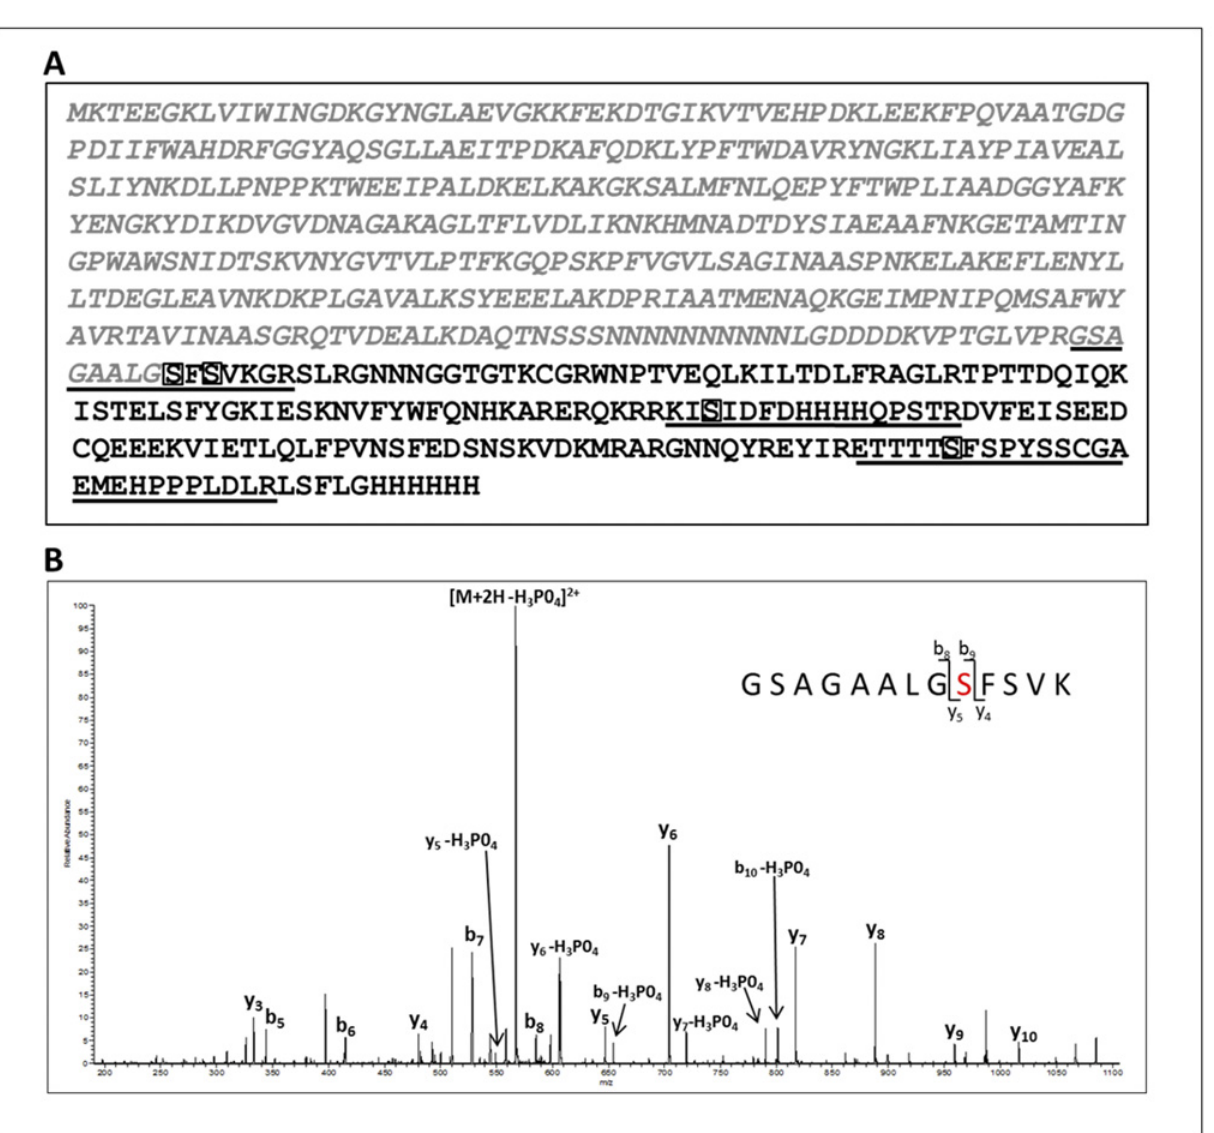
Fig 9. Identification of in vitro WOX5 phosphorylation sites. (A) The sequence of the MBP fused WOX5 protein is shown: the N-terminal MBP fusion tag (grey italics) and the 182aa WOX5 sequence with the C-terminal 6X-His tag (black). Note, the N-terminal Met residue of WOX5 was changed to Gly. Confirmed phosphorylation sites, Ser 2 , Ser 4 , Ser 88 , and Ser 158 are boxed. The phosphopeptides identified by mass spectrometry are underlined. (B) Collision-induced low resolution fragmentation spectrum of the phosphopeptide GSAGAALGSFSVK, encompassing the C-terminal end of the fusion tag and the N-terminal end of WOX5. The presence of the phosphorylated b 9 (theoretical m/z 654.32, observed m/z of 654.33) and y 5 (theoretical m/z 549.30, observed m/z of 549.33) ions, and the unphosphorylated b 8 (theoretical m/z 585.30, observed m/z of 585.17) and y 4 (theoretical m/z 480.28, observed m/z of 480.30) ions, confirms Ser 2 as the site of